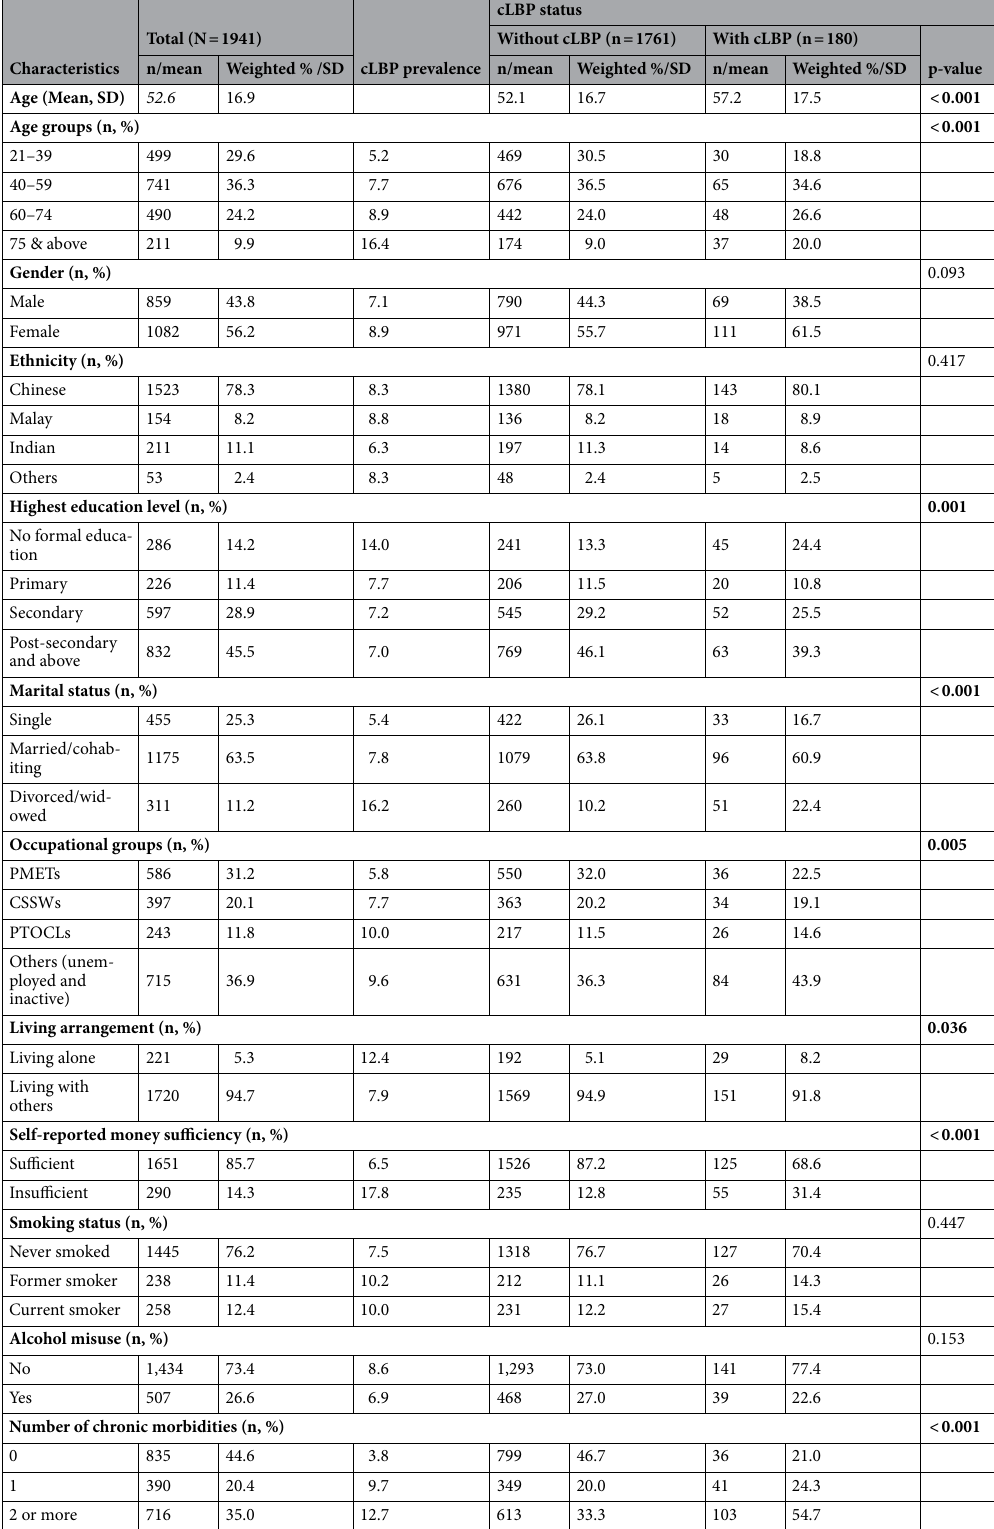
Table 1. Characteristics of all participants and by chronic low back pain status. Significant values are in bold. cLBP chronic low back pain, PMETs Professionals, Managers, Executives and Technicians, including Major Group 1–3, X), CSSWs Clerical, Sales and Service Workers, including Major Group 4–5, PTOCLs Production and Transport Operators, Cleaners and Labourers, including Major Group 6–9. The weighted % were column